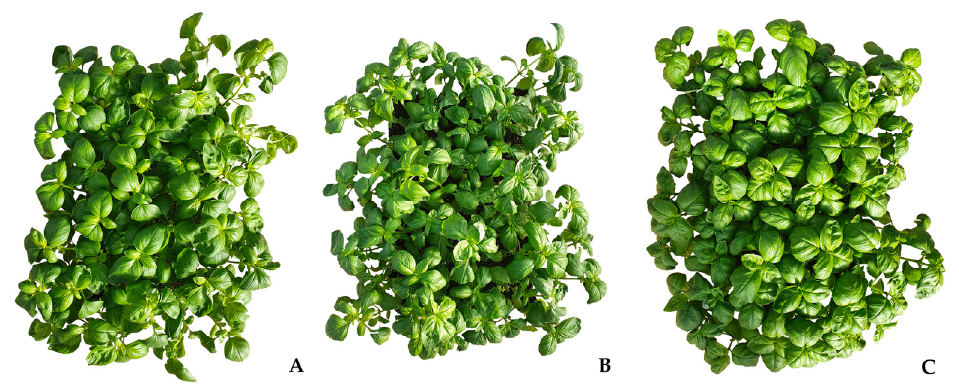
Figure 1. Genovese basil genotype used in the experiment. Aroma 2 ( A ), Eleonora ( B ), and Italiano Classico ( C ).